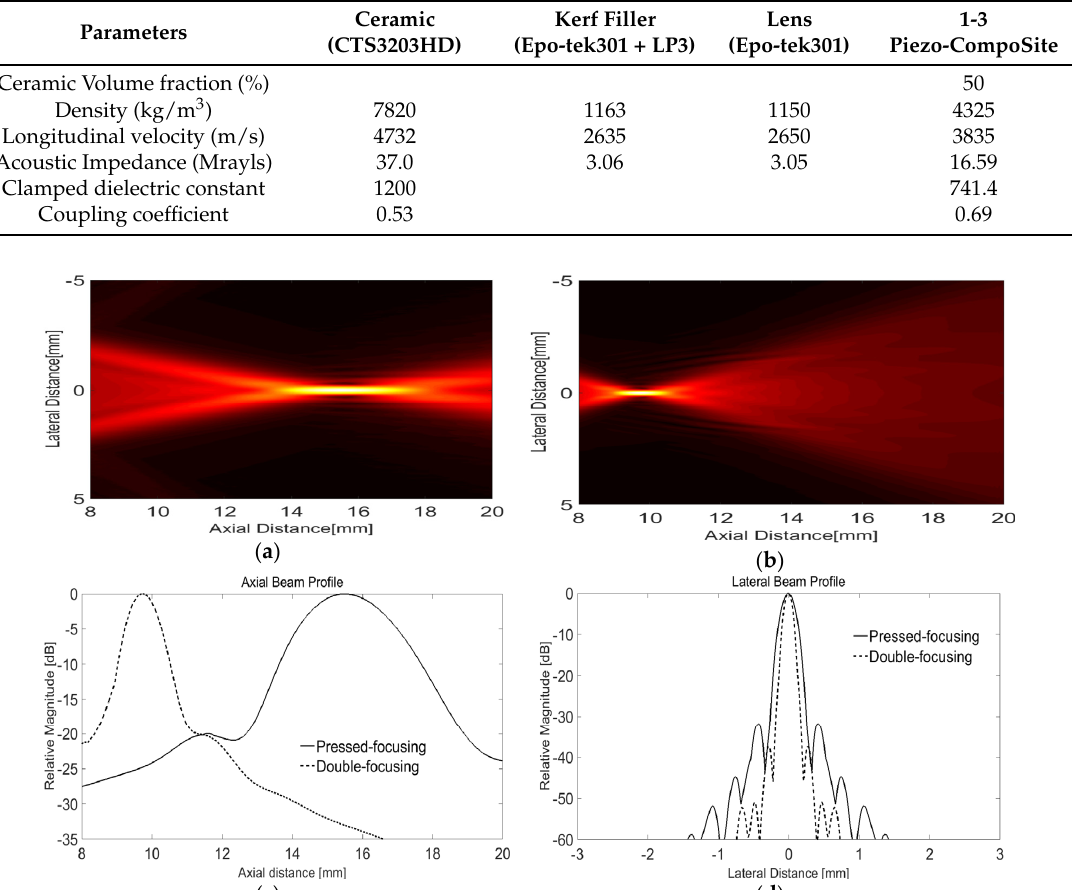
Figure 4. Beam propagation simulated using PZFlex: one-way radiation patterns produced by the concave transducer for initial focusing ( a ) and the double-focused transducer designed in this study ( b ). ( c ) and ( d ) show the lateral and axial beam profiles at the maximum intensity of the radiation patterns.